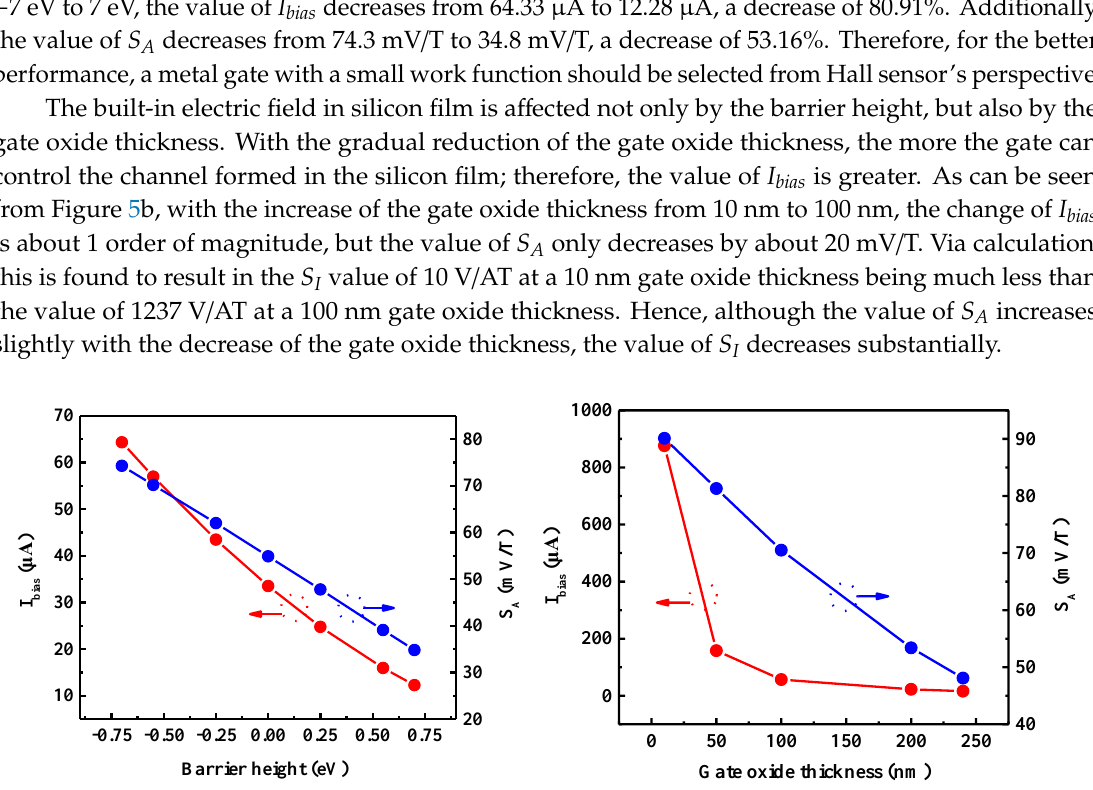
Figure 4. Hall voltage ( V H ) versus magnetic induction ( B ) simulated for sensors with different ( a ) doping concentrations and ( b ) silicon film thicknesses.